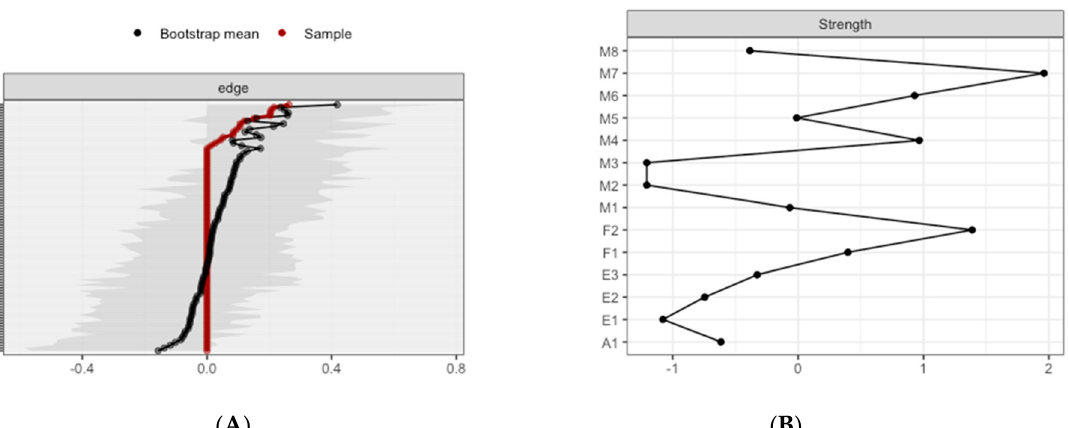
Figure 11. Estimated edge-weights for the estimated network and centrality of nodes. ( A ) Left: Bootstrapped CIs of estimated edge-weights for the estimated network. The red line indicates the sample values and the gray area the bootstrapped CIs. Each horizontal line represents one edge of the network, ordered from the edge with the highest edge-weight to the edge with the lowest edge-weight. ( B ) Right: Centrality of nodes within a network according to ETOC subsample.